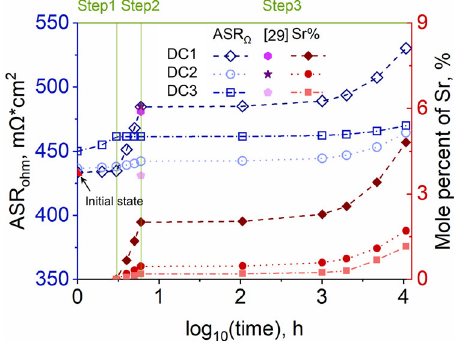
Fig. 6 Predicted ASR ohm change resulting from the oxygen electrode – electrolyte interface reactions. Calculated ASR ohm at 800 °C in DC1, DC2, and DC3 at the three stages of barrier sintering (Step 1), cathode sintering (Step 2), and long-term operation (Step 3) and the amount of Sr accumulated in the IDZ, together with the experimentally measured values 29